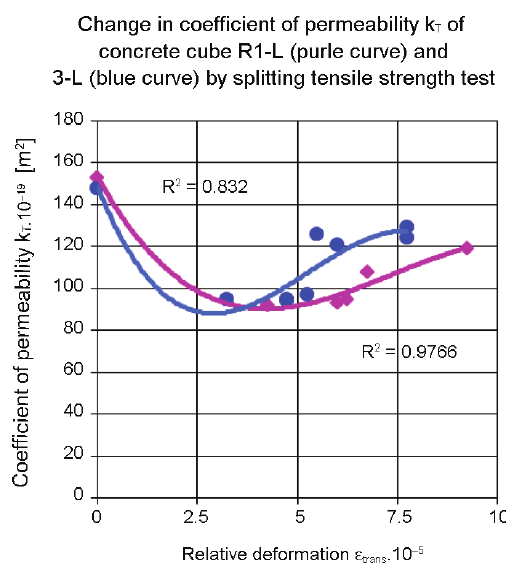
Fig. 10. Dependence of k T /ĺ trans for concrete cube R1-L and